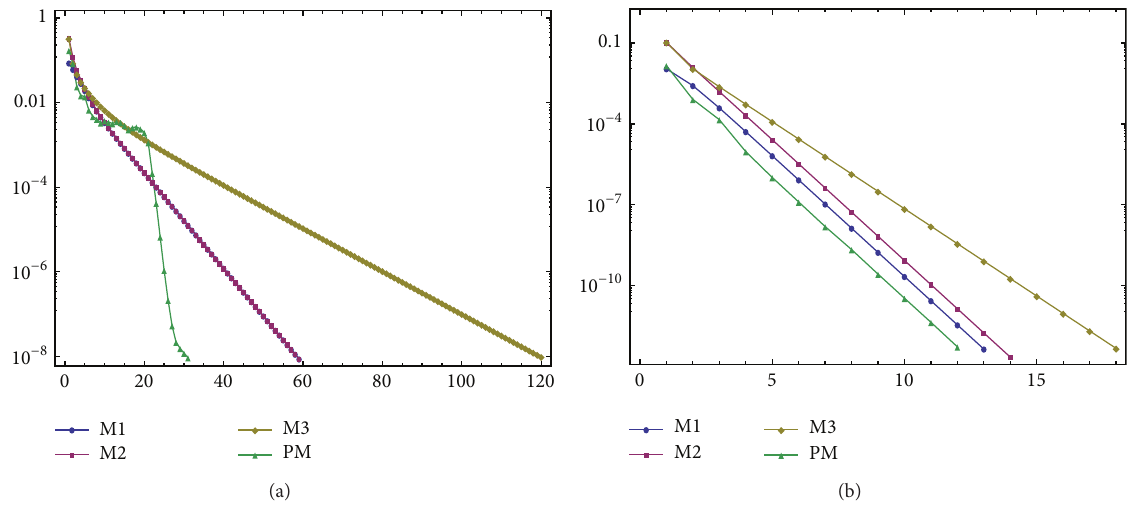
Figure 1: Number of iterations against accuracies for experiment 1 (a) and experiment 2